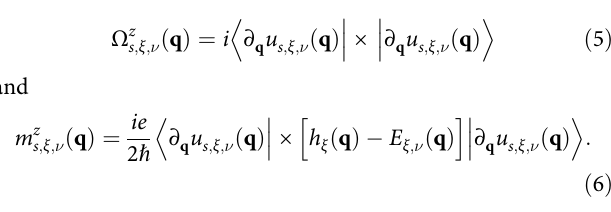
For an isolated TBG, the Berry curvature and the magnetic moment are non-zero only at the Dirac point. In the absence of